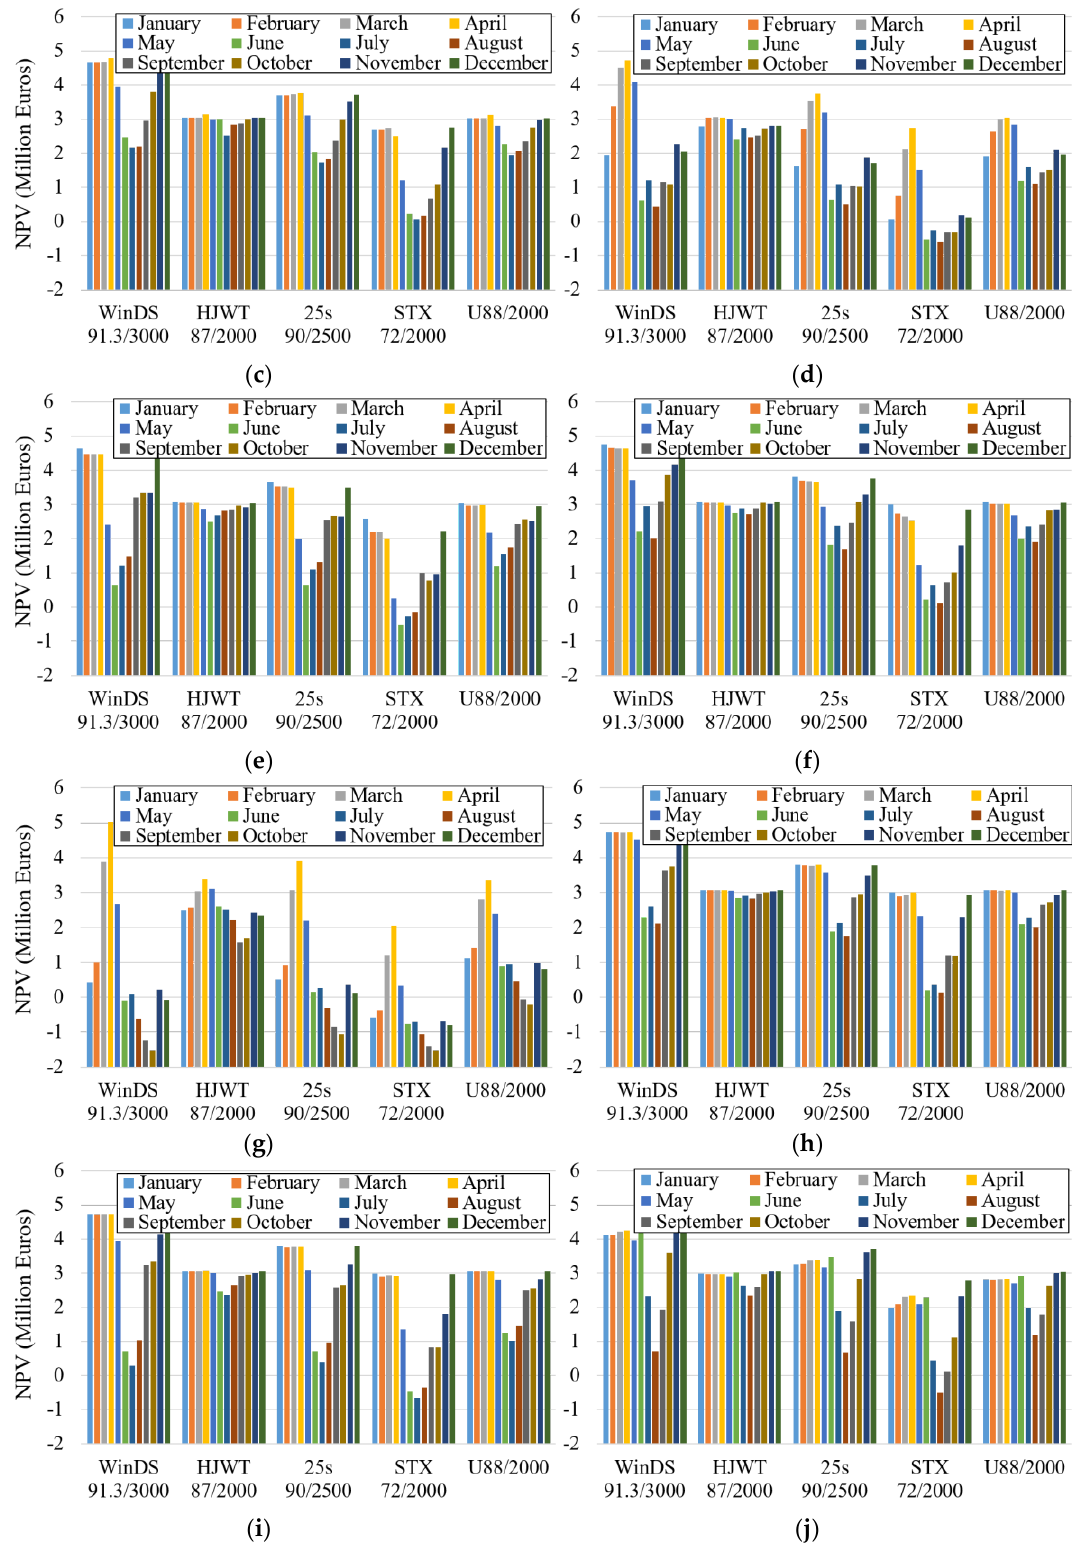
Figure 13. Estimation of LCOE at newly proposed wind farm sites ( a ) Site 1; ( b ) Site 2; ( c ) Site 3; ( d ) Site 4; ( e ) Site 5; ( f ) Site 6; ( g ) Site 7; ( h ) Site 8; ( i ) Site 9; ( j ) Site 10.